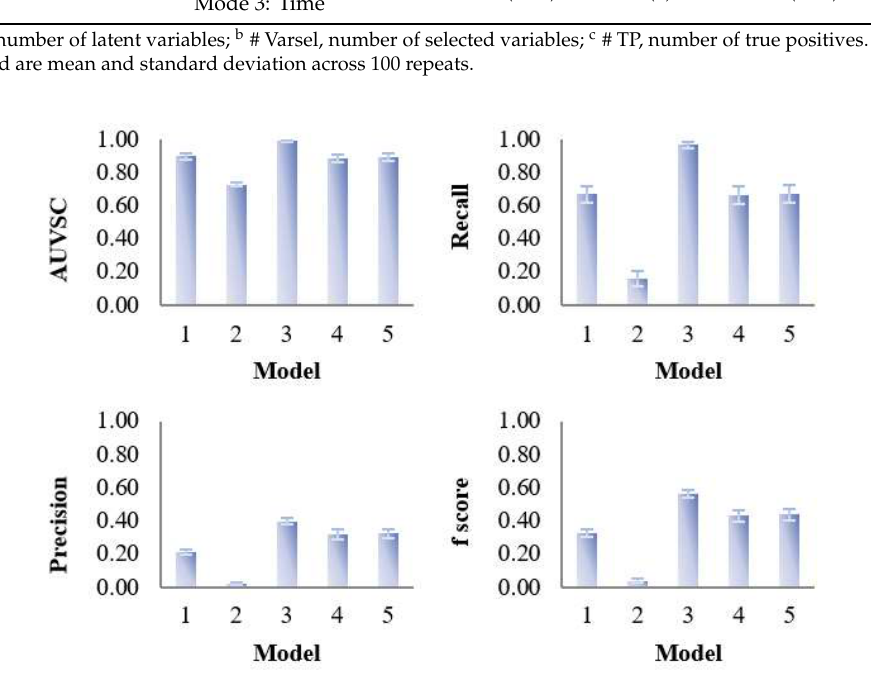
Figure 4. Evaluation of the variable selection performance of five PLS models on 100 simulated datasets. The variable selection performance consists of four criteria—area under the ROC curve (AUVSC), recall, precision, F 1 - score, which were calculated based on the variable selection confusion matrix.